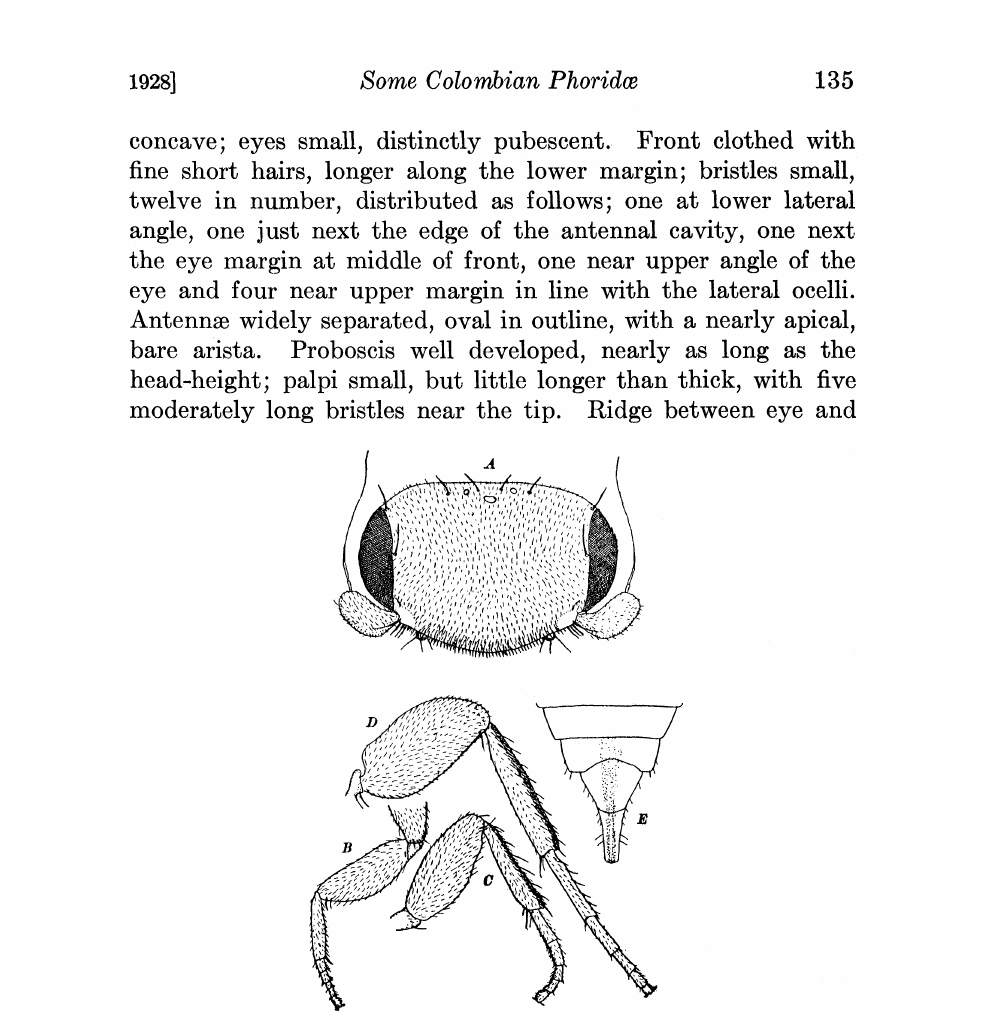
Fig. 1.--Melittophora salti sp. nov., female. A, front view of head; B, C, D. fore, middle and hind leg; E, apex of